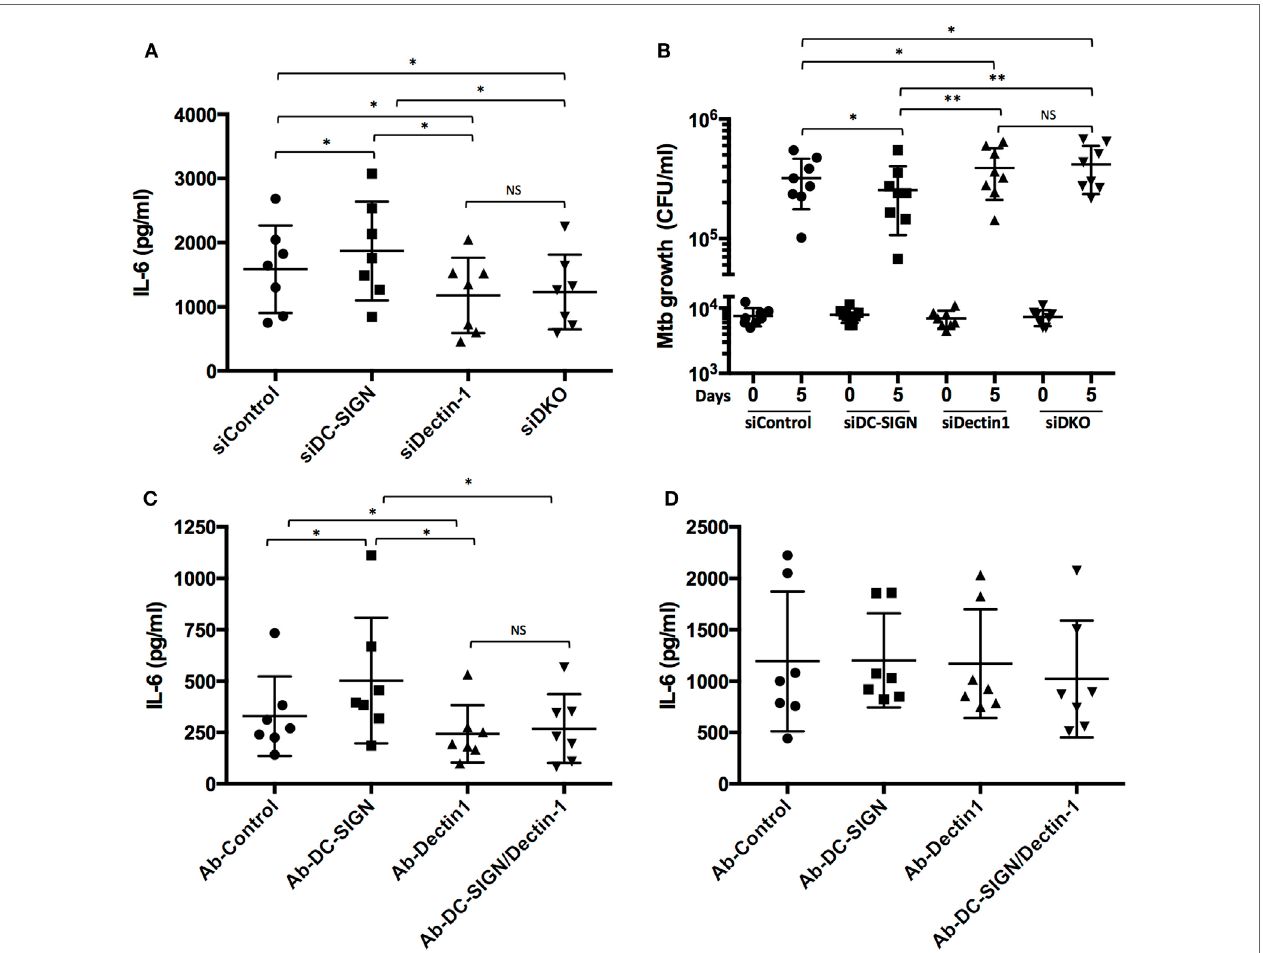
FigUre 5 | DC-SIGN interferes negatively with the activation of M(IL-4) macrophages triggered by Dectin-1. Human monocytes were differentiated into macrophages using M-CSF. At day 5, the macrophages were transfected with siRNA targeting DC-SIGN (siDC-SIGN, squares) and Dectin-1 (siDectin-1, upward triangle), both siRNAs (siDKO, downward triangle), or a non-targeting siRNA (siControl, circles). The following day, the cells were activated with IL-4 (20 ng/ml) for 48 h to induce M(IL-4) program and the C-type lectin receptor expression. (a) Assessment of IL-6 secretion by ELISA analysis. The cells were infected with Mtb at MOI of 3 bacteria to 1 cell. At 18 h p.i ., the supernatant from these cells was collected. Results are expressed as vertical scatter plots, and as mean ± SD ( n = 7 donors). (B) Assessment of Mtb intracellular growth by colony forming unit (CFU) assay. The cells were infected with Mtb (MOI of 0.2 bacteria to 1 cell), and the intracellular growth of the bacteria was followed at 4 h (day 0, left) or 120 h (day 5, right). Results are expressed as vertical scatter plots, and as mean ± SD ( n = 8 donors). Two-tailed Wilcoxon (matched-paired/nonparametric): *P < 0.05, ** P < 0.01; NS, not significant. ( c,D) Upon differentiation until day 5, macrophages were then activated with IL-4 for 48 h. Prior to stimulation, M(IL-4) macrophages were pre-treated for 30 min with blocking antibodies for either DC-SIGN or Dectin-1, or both. An irrelevant antibody was used as a control. M(IL-4) macrophages were then treated with either (c) cytochalasin D (1 μ g/ml), β -glucan (10 µg/ml) and ManLAM (10 µg/ml), or (D) LPS (1 µg/ml) and ManLAM (10 µg/ml). After 24 h, the supernatants were collected and the production of IL-6 was measured by for ELISA